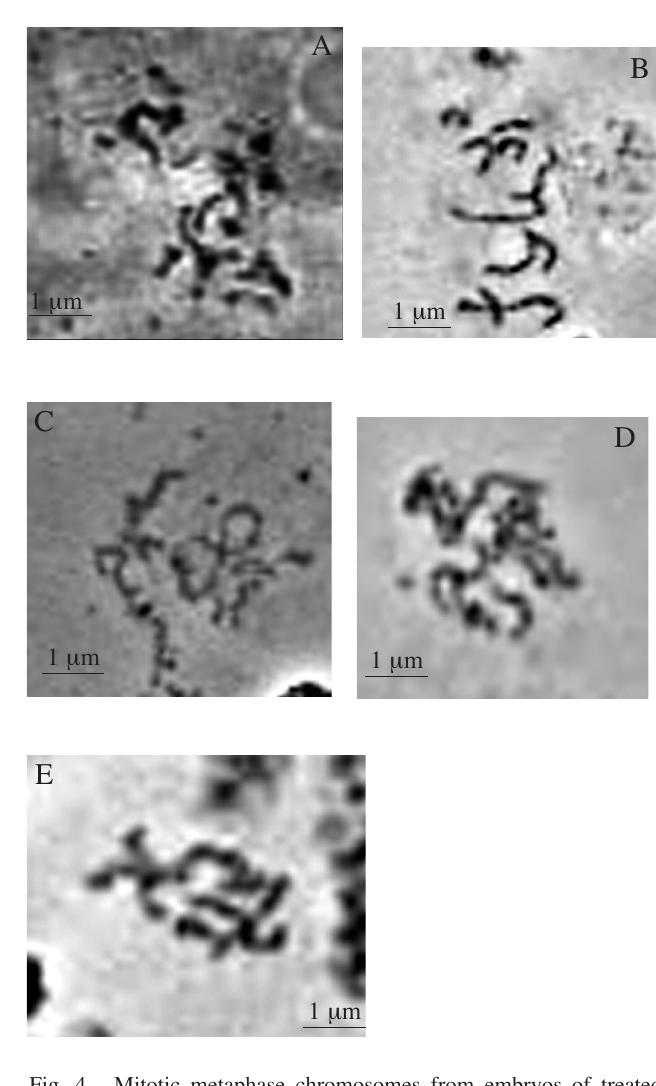
Fig. 4 - Mitotic metaphase chromosomes from embryos of treated Grape phylloxera with gamma ray, showing sticky chromo- somes at deferent doses: A-B at dose 10 Gy; C) at dose 20 Gy, D-E) at dose 30 Gy.